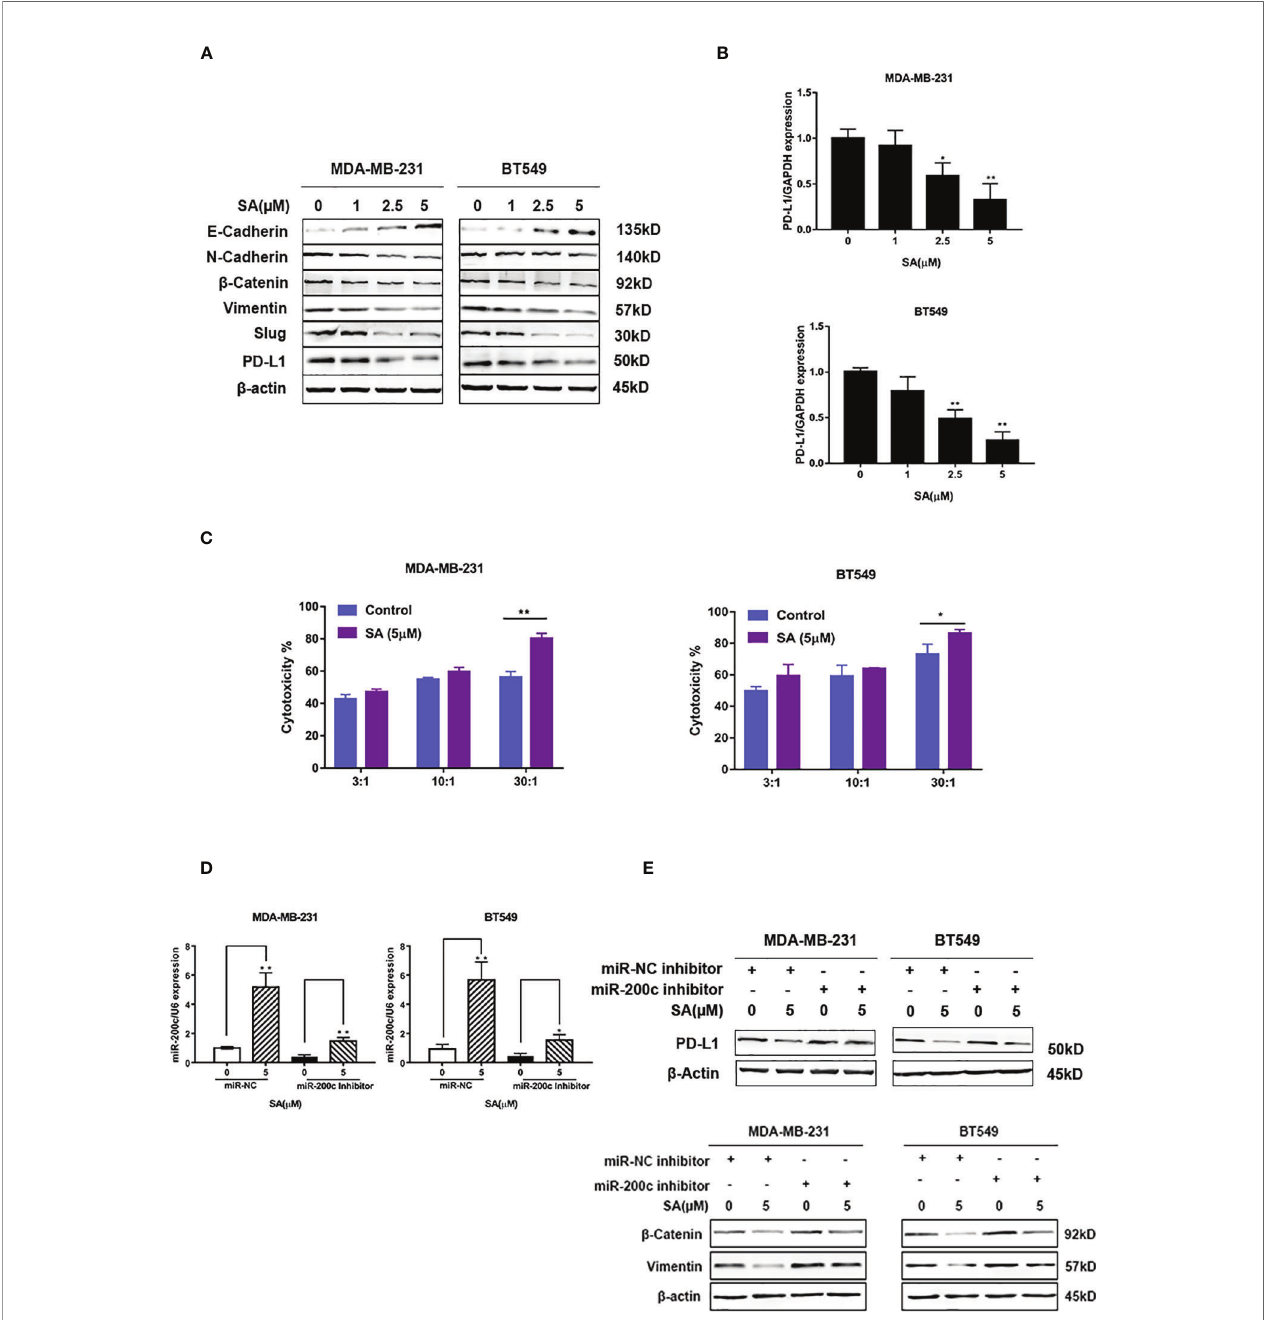
FIGURE 7 | SA inhibits PD-L1 through the up-regulation of miR-200c. (A) Western blot analysis of EMT markers and PD-L1 after SA treatment. (B) Real-time PCR analysis of PD-L1 in MDA-MB-231 and BT549 cells after SA treatment (Compared to the control group, * p < 0.05,** p < 0.01). (C) LDH cytotoxicity of MDA-MB- 231 and BT549 cells with or without SA treatment at different effector to target (E: T) ratios (Compared to the control group, * p < 0.05,** p < 0.01). (D) Real-time PCR analysis of miR-200c after SA treatment with miR-200c inhibitor interference. (E) Western blot analysis of PD-L1, vimentin, and b -catenin after SA treatment with miR-200c inhibitor